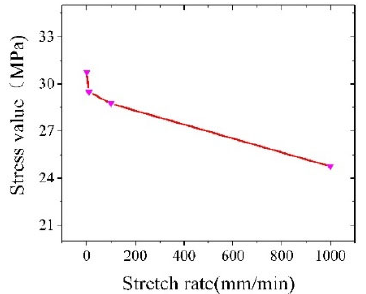
Figure 19. The effect of the tensile rate on the magnitude of the stress reduction. Figure 19. The e ff ect of the tensile rate on the magnitude of the stress reduction.